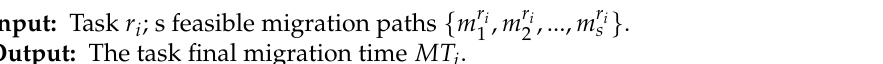
Algorithm 2 Service Migration